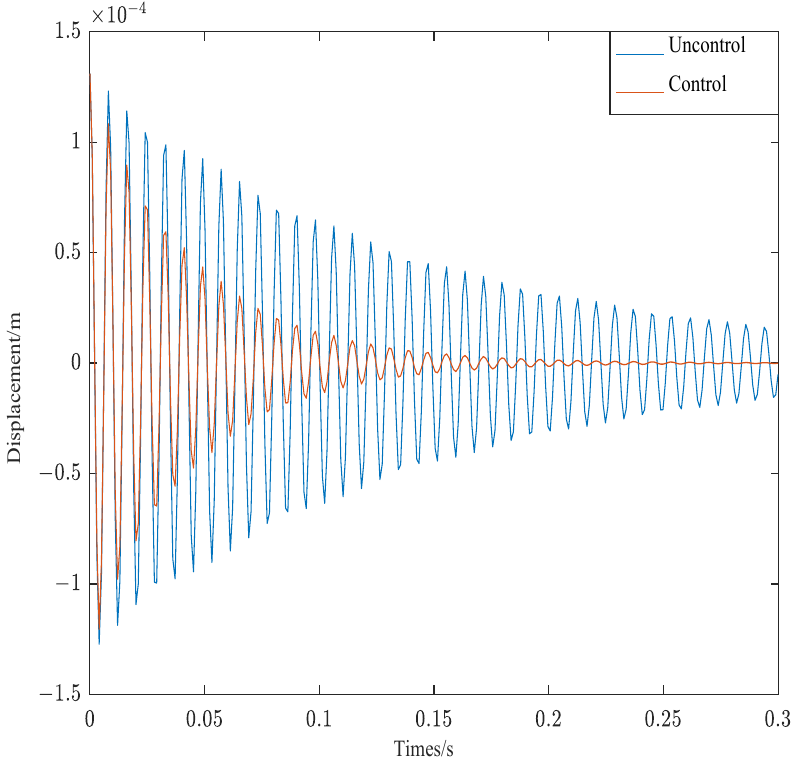
Figure 9. Displacement of structure 1 and structure 2.